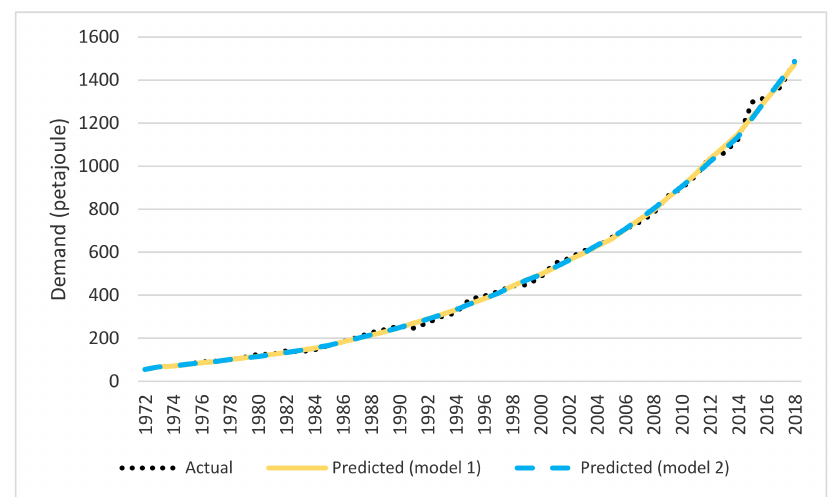
Figure 4. Comparison of actual vs. predicted total energy demand